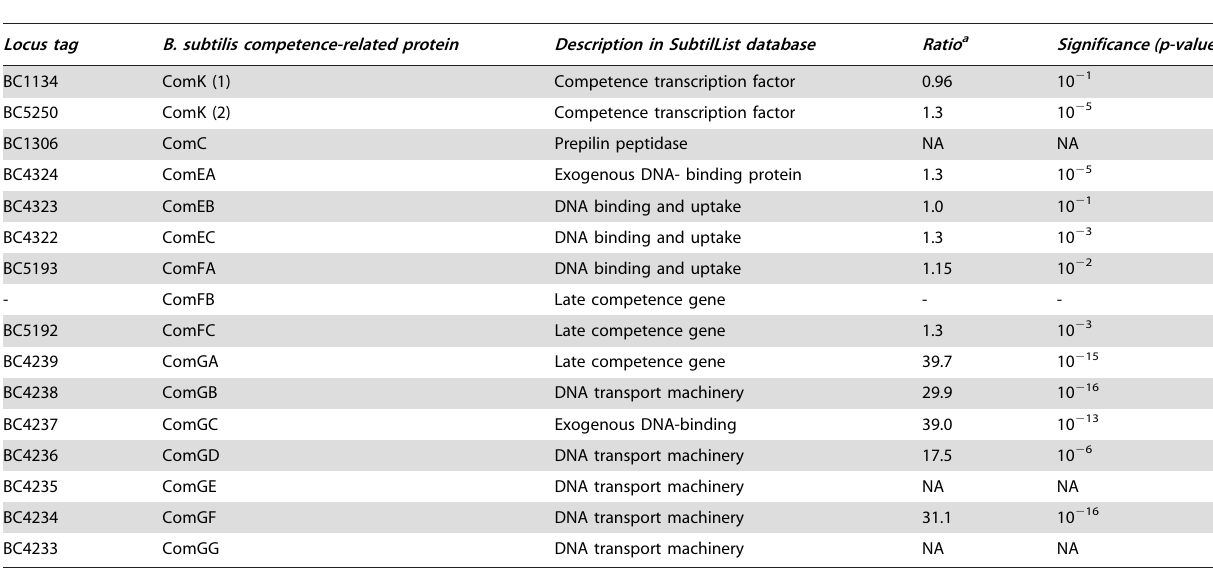
Table 1. Transcriptional changes of the functional homologues of the B. subtilis DNA uptake apparatus in B. cereus ATCC15479 upon overexpression of B. subtilis